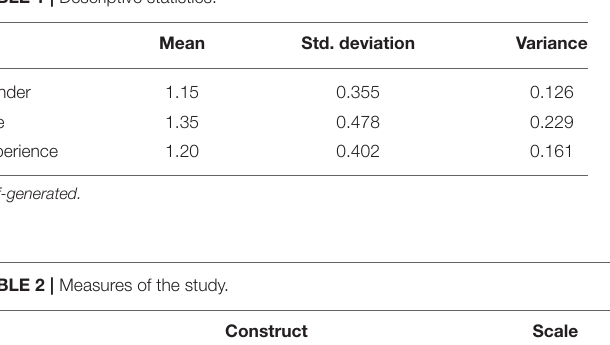
TABLE 1 | Descriptive statistics.